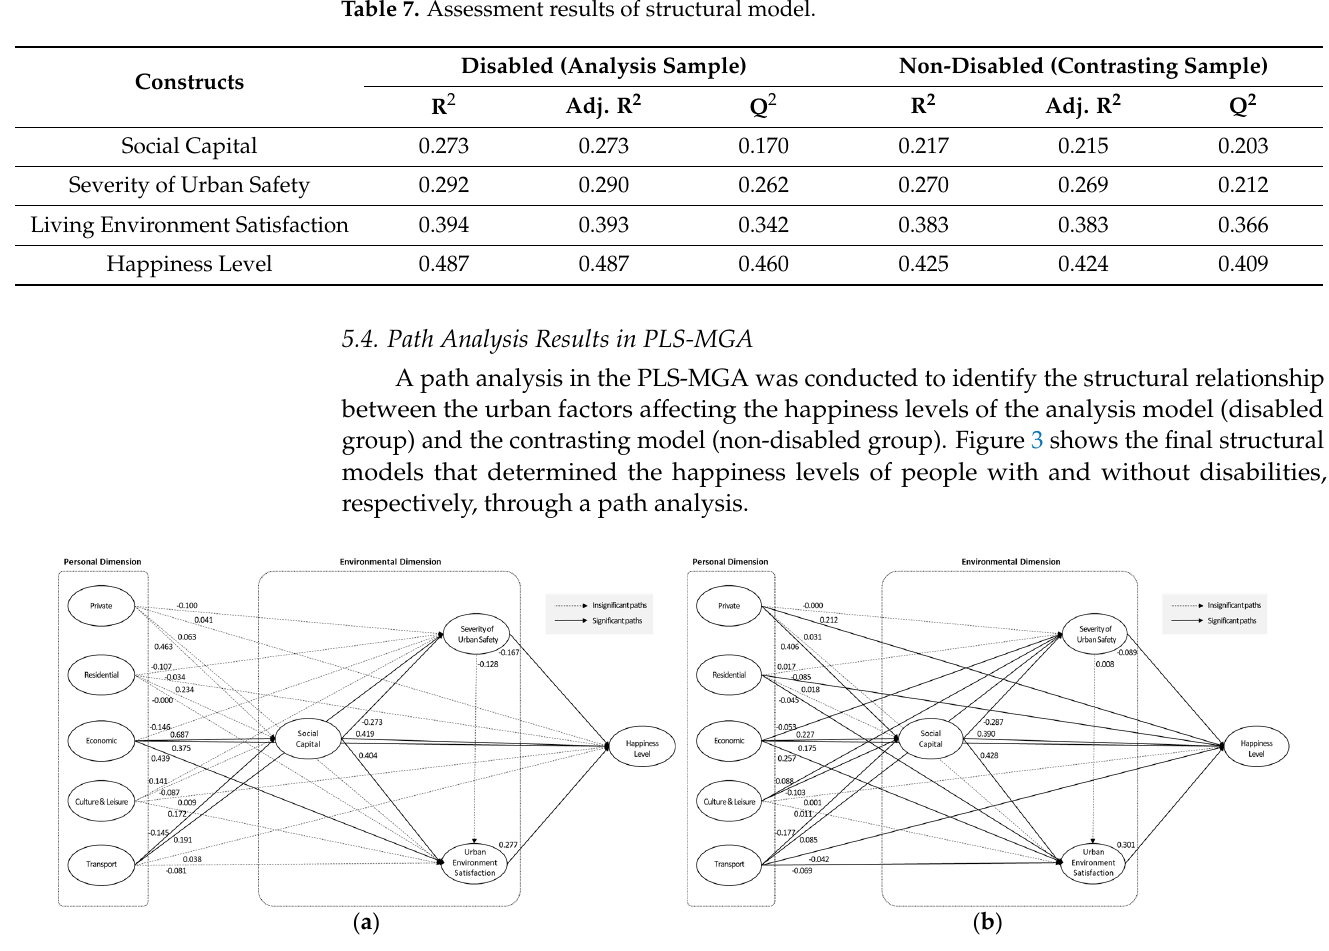
Figure 3. Final structural models for determining happiness levels: ( a ) disabled; ( b ) non-disabled.